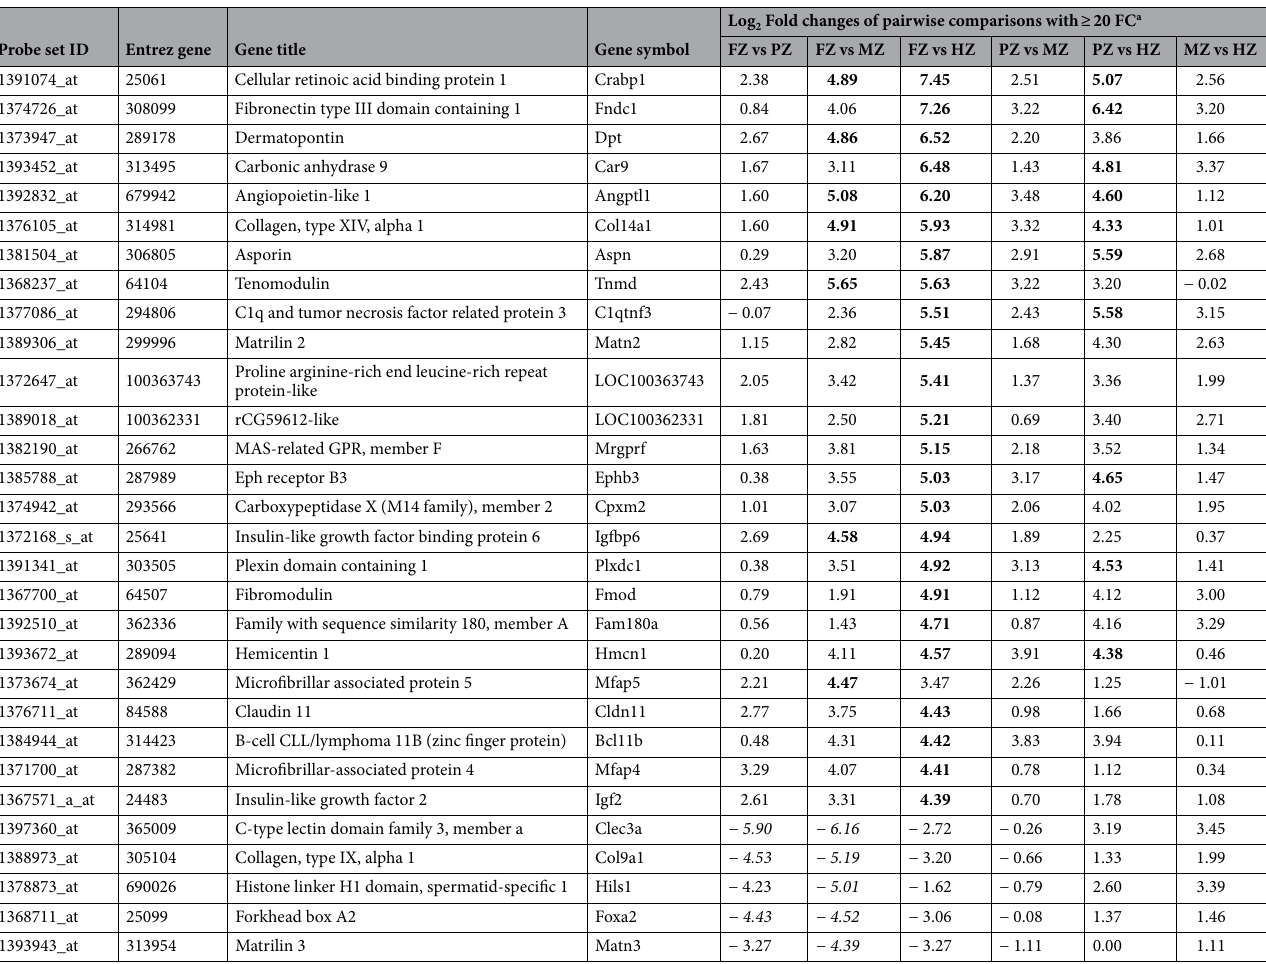
Table 3. Top 30 differentially expressed genes that showed strong modulation in at least one of the six pairwise comparisons where MCC zones were compared against each other at ≥ 20 -fold change cut-off value (log 2 20 FC = 4.32, bold and ilatlics indicate gene upregulation and downregulation respectively above the cut- off value). a For each gene in the pairwise comparison, there were 2 normalized intensity values (one for each group) representing the expression levels. The fold change (FC) value for the gene is calculated by dividing the larger value by the smaller one, then a positive sign is assigned if the gene is upregulated, in other words the gene expression value of the sample (the first group) is greater than the reference (the second group). On the other hand, downregulation of the gene (negative sign) indicates that the gene expression value of the sample is less than the